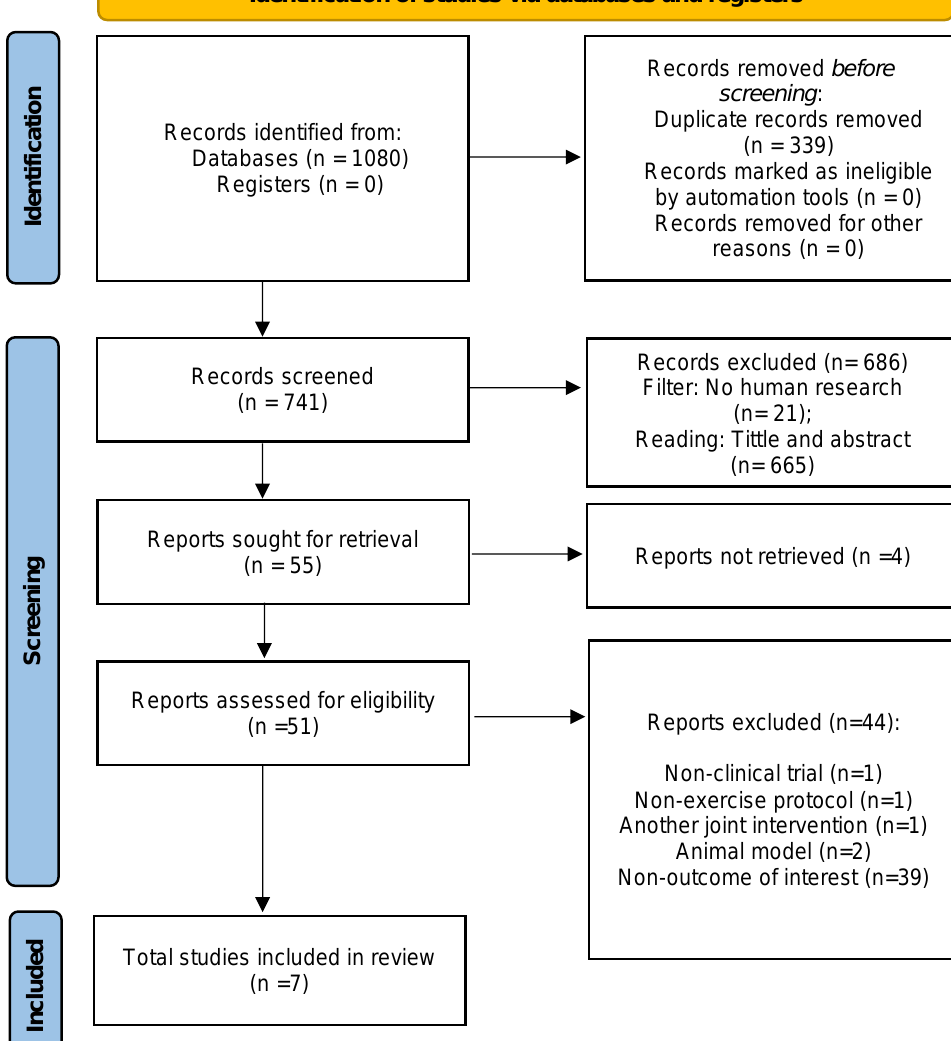
Figure 1. PRISMA 2020 flow diagram